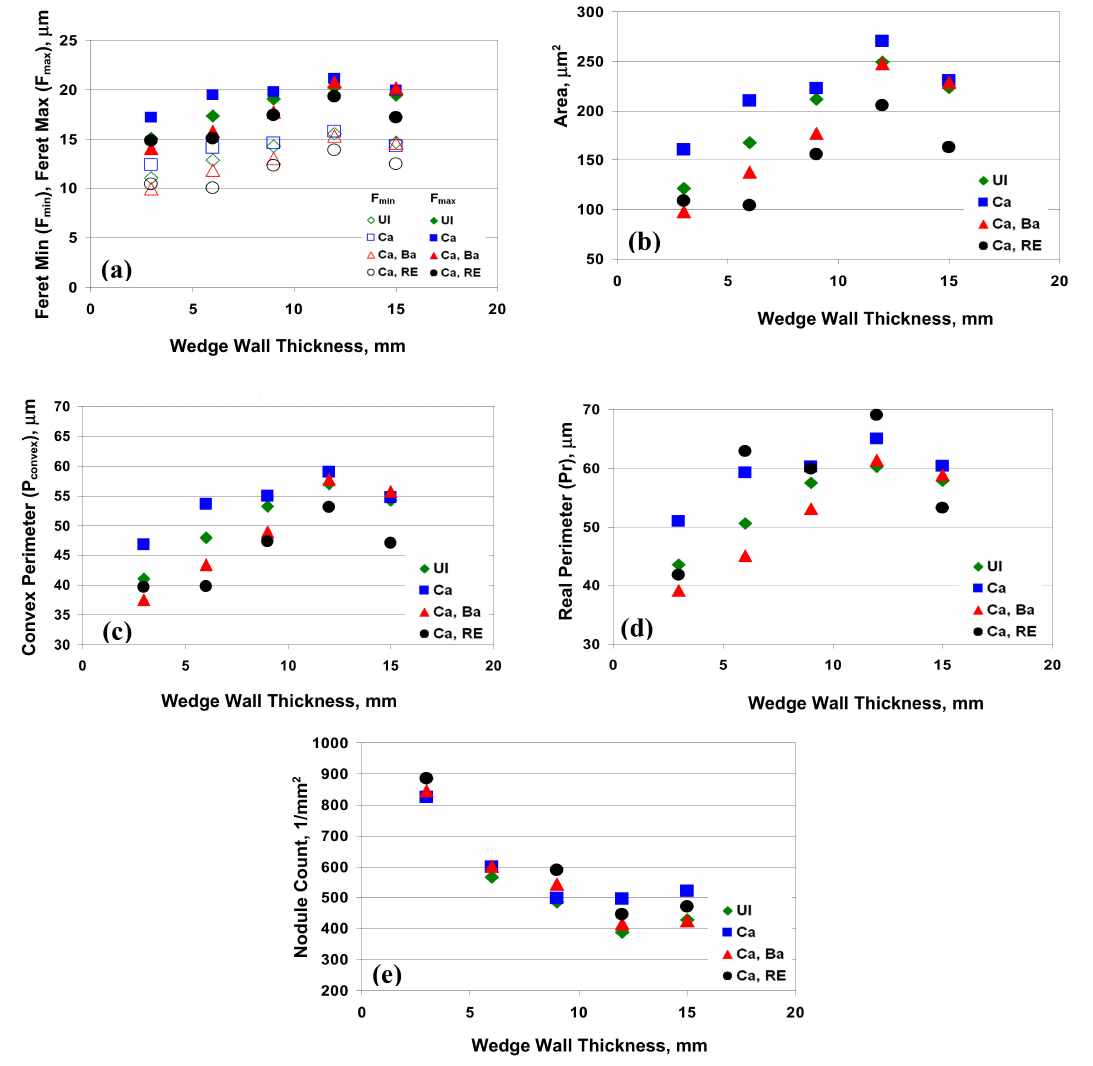
Figure 9. Influence of the wedge section size and inoculation on the average values of Minimum and Maximum Ferret ( a ), Area ( b ), Convex Perimeter ( c ), Real Perimeter ( d ), and Nodule count ( e